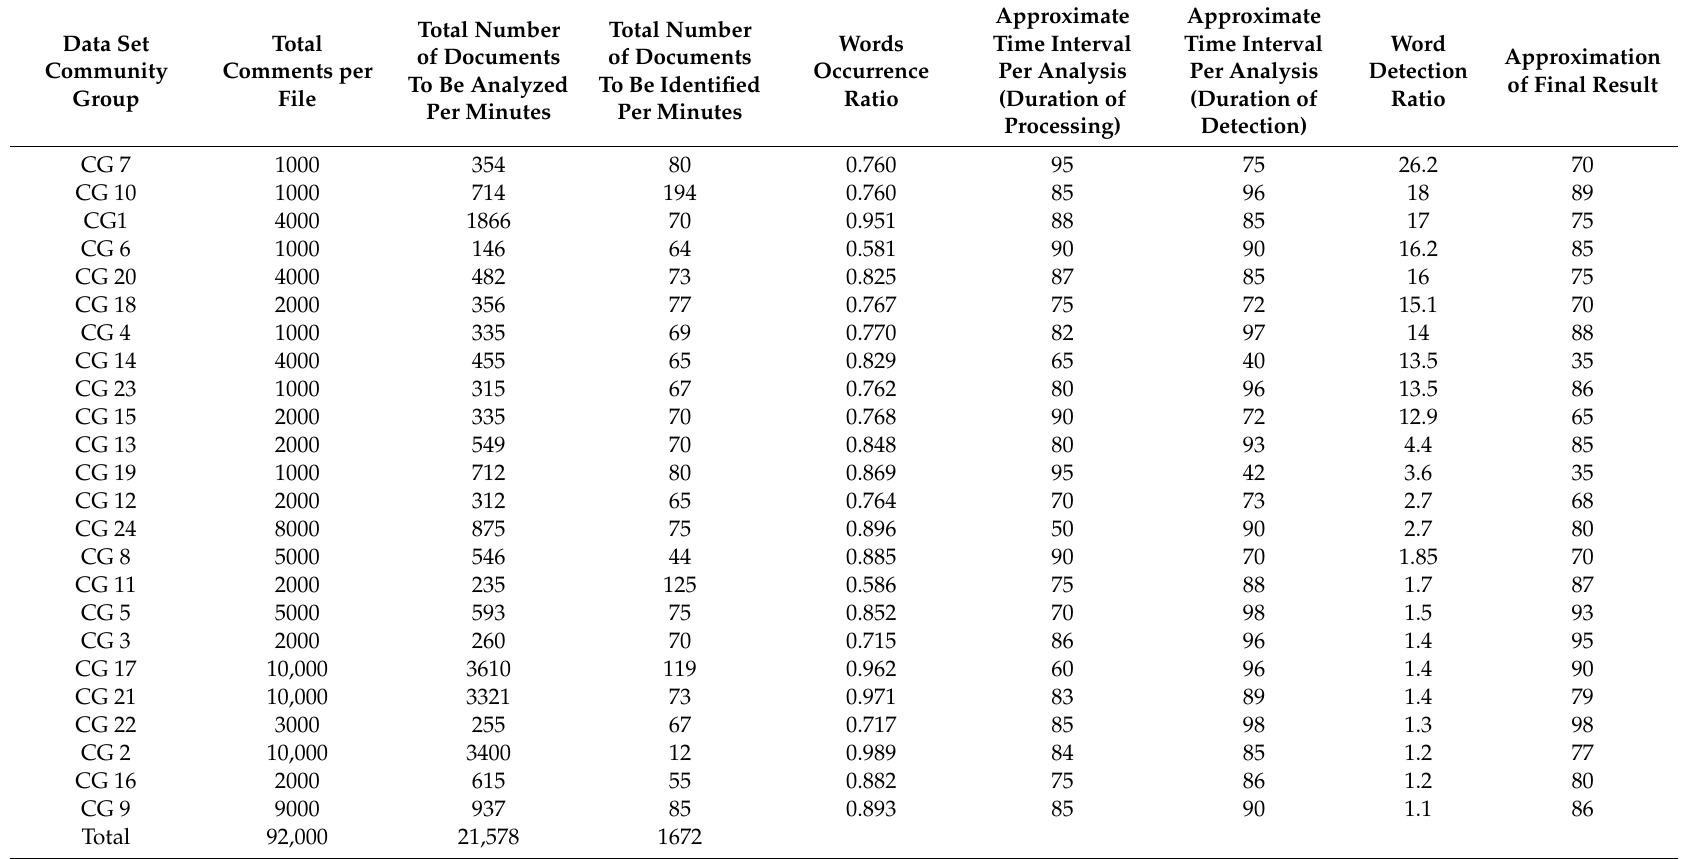
Table 2. Community group classification